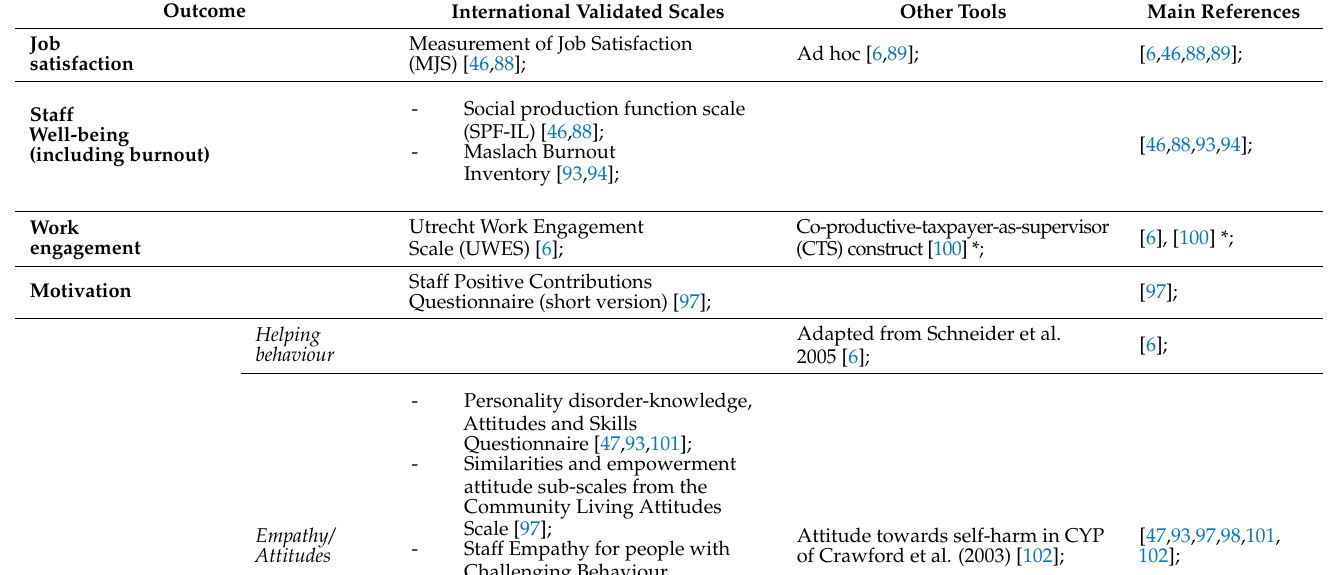
Table 7. Measures and metrics of outcomes for